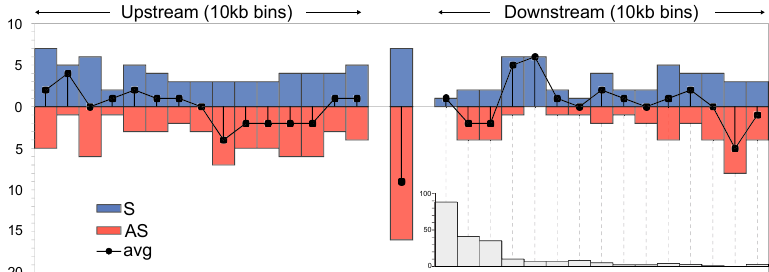
Figure 2. Chicken ERV integration landscape relative host genes (upstream, intragenic, and downstream) and orientation. Blue and red histograms show the number of identified host genes at various distances to the ERV in sense (blue) and antisense (red) relative orientations, and average points are indicated for each bin. The grey histogram insert indicates the number of analyzed genes at downstream distances, split into 10 kb bins, with respect to nearby ERVs.